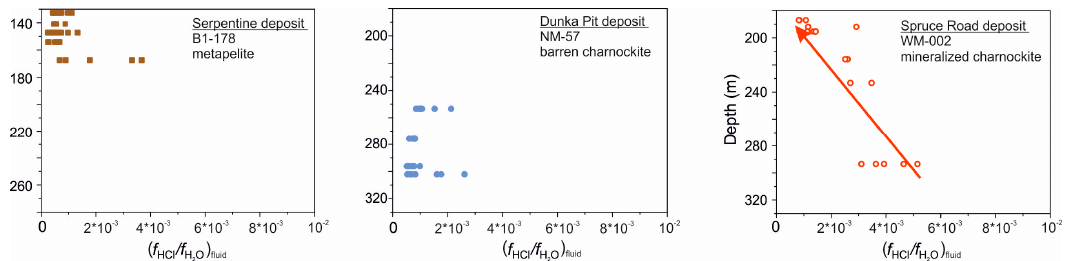
Figure 12. Variation of the ( f HCl / f H2O ) fluid ratios of the fluids in equilibrium with apatite during metamorphism. The top of the plots coincides with the intrusion-footwall contact. Fugacity of chlorine shows a distinct increasing trend with increasing depth in the footwall in the studied mineralized drill cores. In the barren drill core, however, the ( f HCl / f H2O ) fluid ratio decreases.